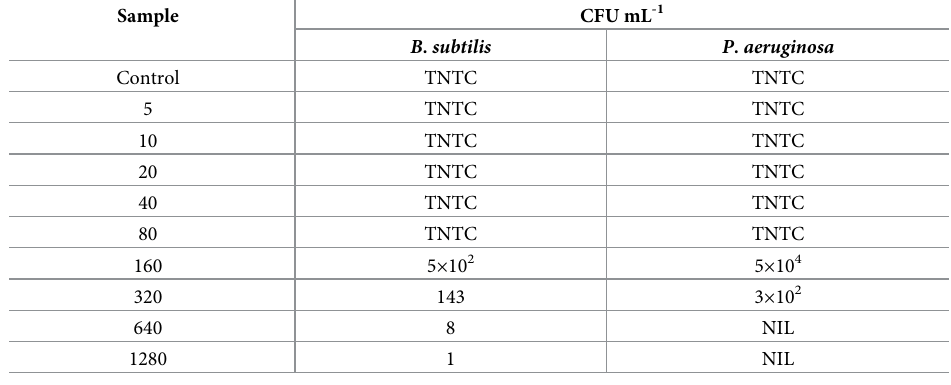
Table 2. Minimum bactericidal concentration (MBC) of sunflower oil/FA–CSNPs bionanocomposite against B . subtilis and P . aeruginosa